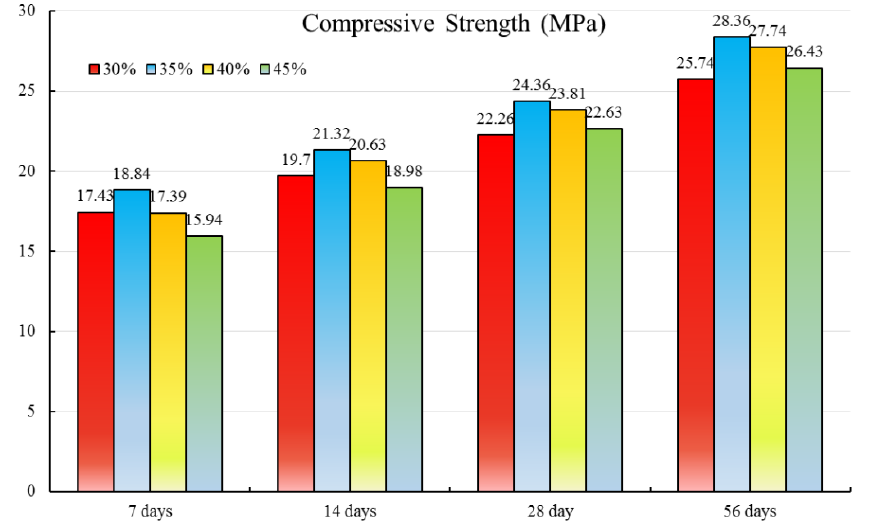
Figure 6. Compressive strength of the Group Ⅱ specimens.